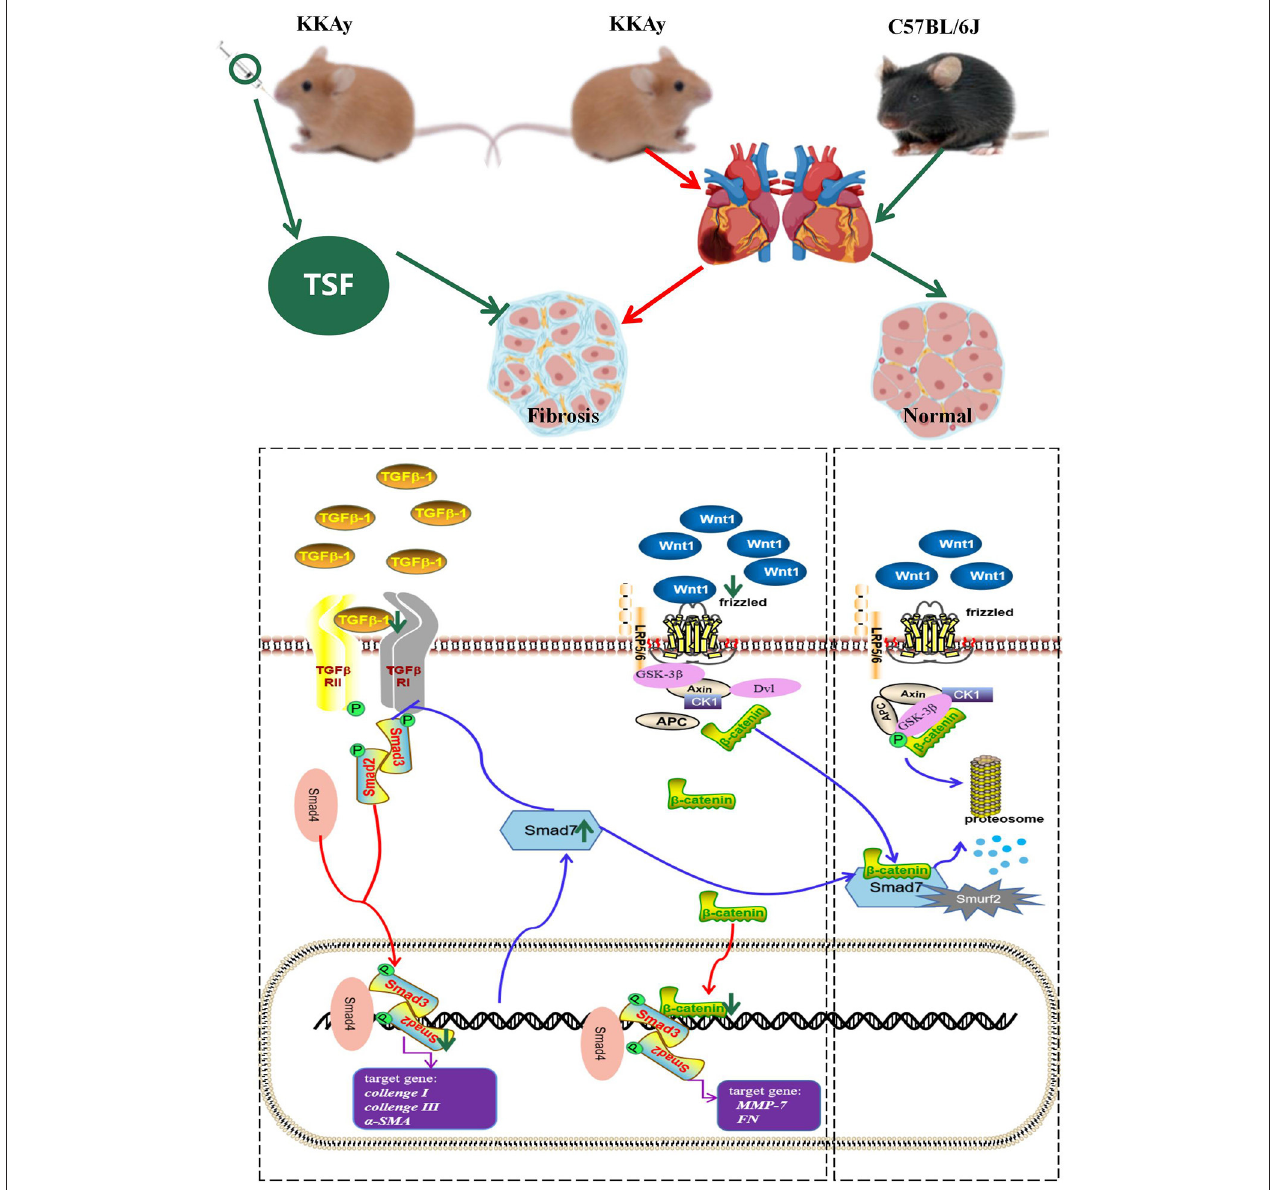
FIGURE 6 | Schema of the possible mechanism of antifibrosis action of TSF. In the TGF- β /smad pathway, TSF decreased the expression of TGF- β 1, inhibited the phosphorylation of Smad2/3, and increased the expression of Smad7, which promoted the degradation of catenin. Meanwhile, TSF also inhibited the Wnt pathway and further promoted β -catenin phosphorylation and degradation. The green arrow represents the effect of